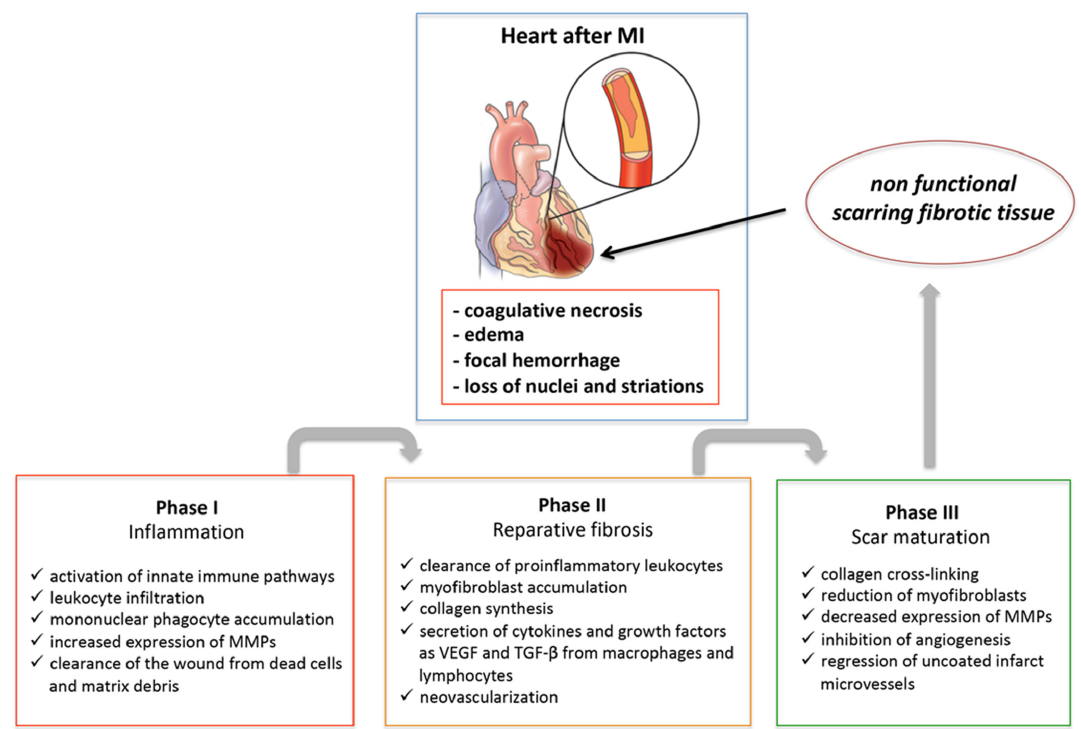
Figure 1. Schematic representation of the healing process of the myocardium after acute myocardial infarction (MI). At the end of the process, the result will be the structural but not functional restoration of the heart. MMPs, matrix metalloproteinases; VEGF, vascular endothelial growth factor; TGF- β , transforming growth factor- β .